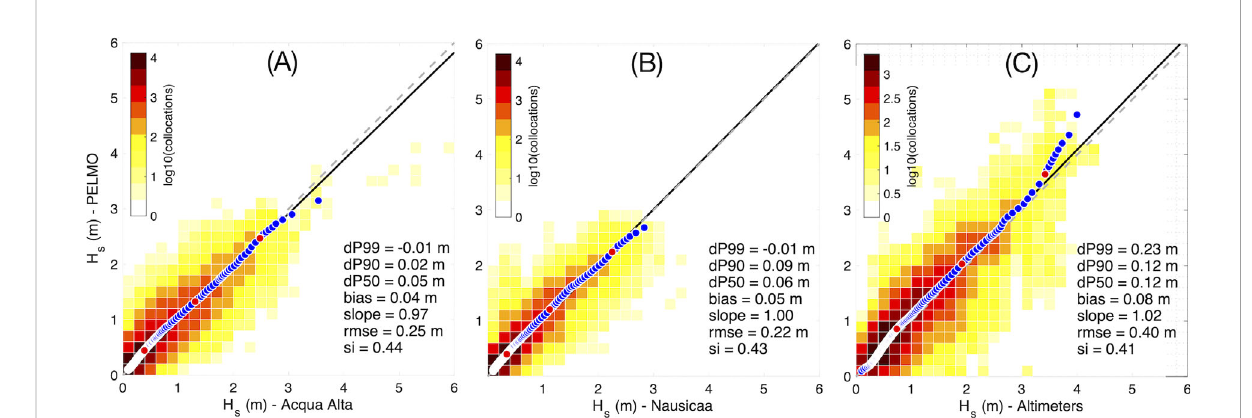
FIGURE 7 Validation of the wave model in all conditions ( H s ≥ 0 : 1 m) at the “ Acqua Alta ” (A) and “ Nausicaa ” (B) stations, and over the whole Adriatic Sea using satellite altimeters (C) . The black line is the linear regression line of the data (reference 1:1 line is gray colored and dashed). Blue dots represent the percentiles of the quantile-quantile plot, from 1 st to 99.9 th ; red dots represent the 50 th , 90 th and 99 th percentile (from left to right),